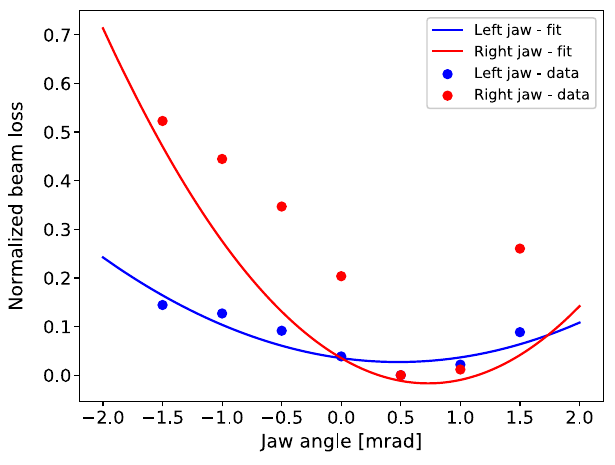
FIG. 15. Beam-based angular alignment.